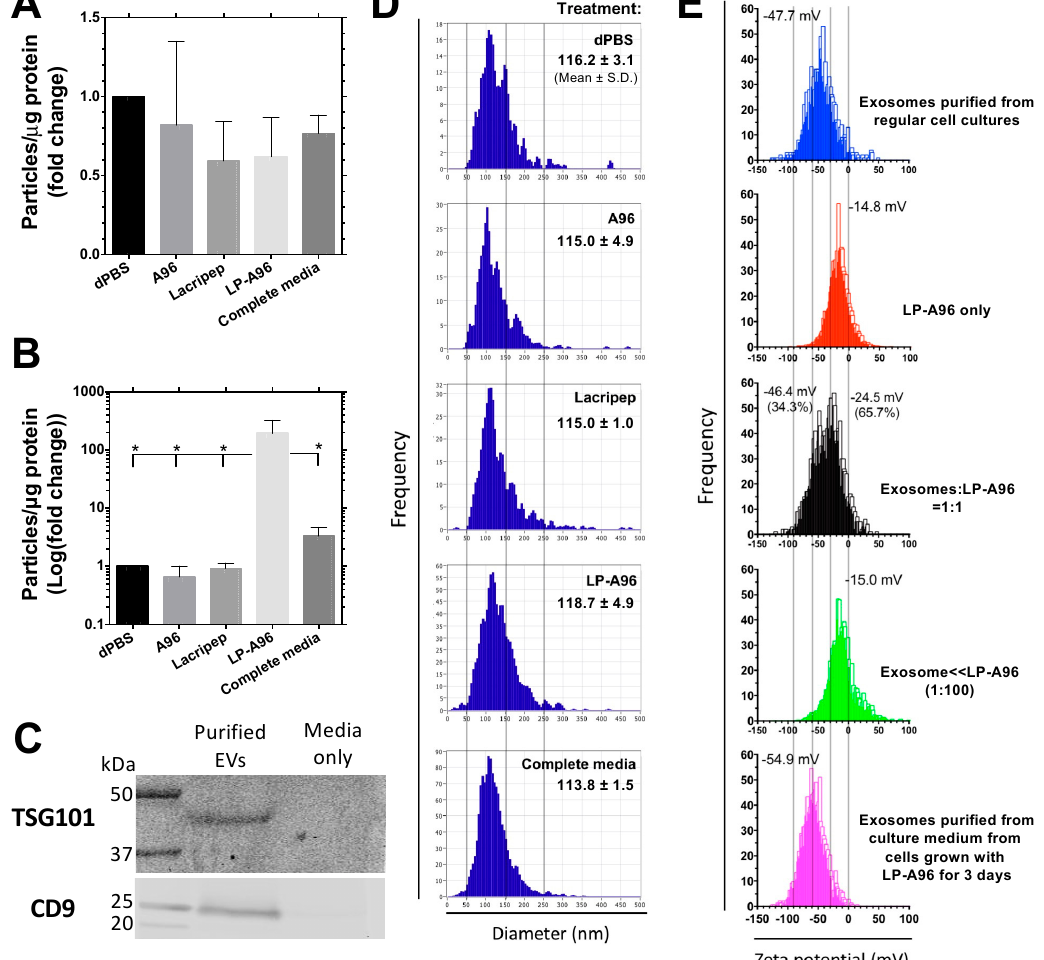
Figure 3. LP-A96 activates exosome biogenesis in corneal epithelial cells. ( A ) Nanoparticle tracking analysis was used to quantify extracellular vesicles (EVs) in the collected HCE-T cell culture media under each treatment at near maximum confluency. Cells cultured to 80~90% confluency were starved for another 24 h using basal media prior to the treatment. EVs in the culture media were purified after 3 days of treatment. ( B ) EVs in the collected HCE-T cell culture media under each treatment at subconfluency (30%). Cells were supplemented with different agents upon seeding (0.5 × 10 5 cells/well in 12-well plate). EVs in the culture media were purified after 3 days of seeding. The raw increase in EV amount upon LP-A96 treatment was corrected based on the Western blot-based analysis (Appendix A Figure A2) before being analyzed for fold change. For ( A , B ), all treatments were at 1 µ M. ( C ) EVs collected after LP-A96 treatment were enriched in the exosome markers CD9 and TSG101. ( D ) Bar graphs show the size distribution of purified exosomes. The three parallel gray lines indicate 50, 150, and 250 nm, respectively. Representative data from three independent sets of the experiment is shown. Inserted numbers indicate mean hydrodynamic diameter of purified exosomes. ( E ) Zeta potential analyses of exosomes, LP-A96, and combinations of both at different ratios. The four parallel gray lines indicate − 90, − 60, − 30, and 0 mV, respectively. Inset values are the mean zeta potentials reported by the built-in software. A one-way ANOVA followed by multiple comparisons was used for statistical comparison. * p < 0.05. Mean ± SD.